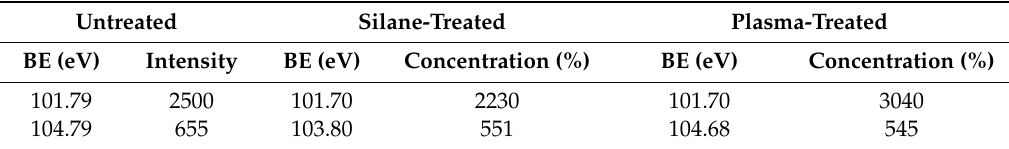
Table 1. Si 2p binding energy and concentration of untreated, silane-treated, and plasma-treated nanoparticles.